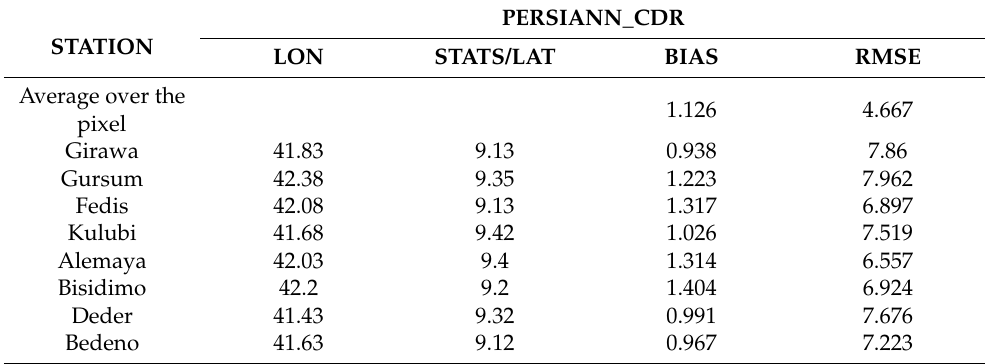
Table 5. Statistical indicators of global precipitation products and station measurements within the